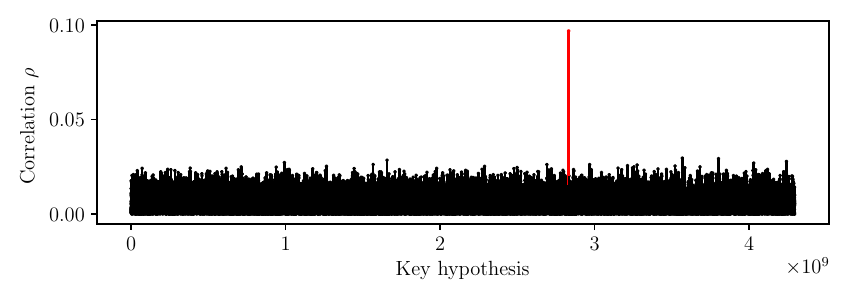
Figure 9: Result for the CNN attack against one column of the fourth round key using 19 000 encryptions. The correct subkey hypothesis is shown in